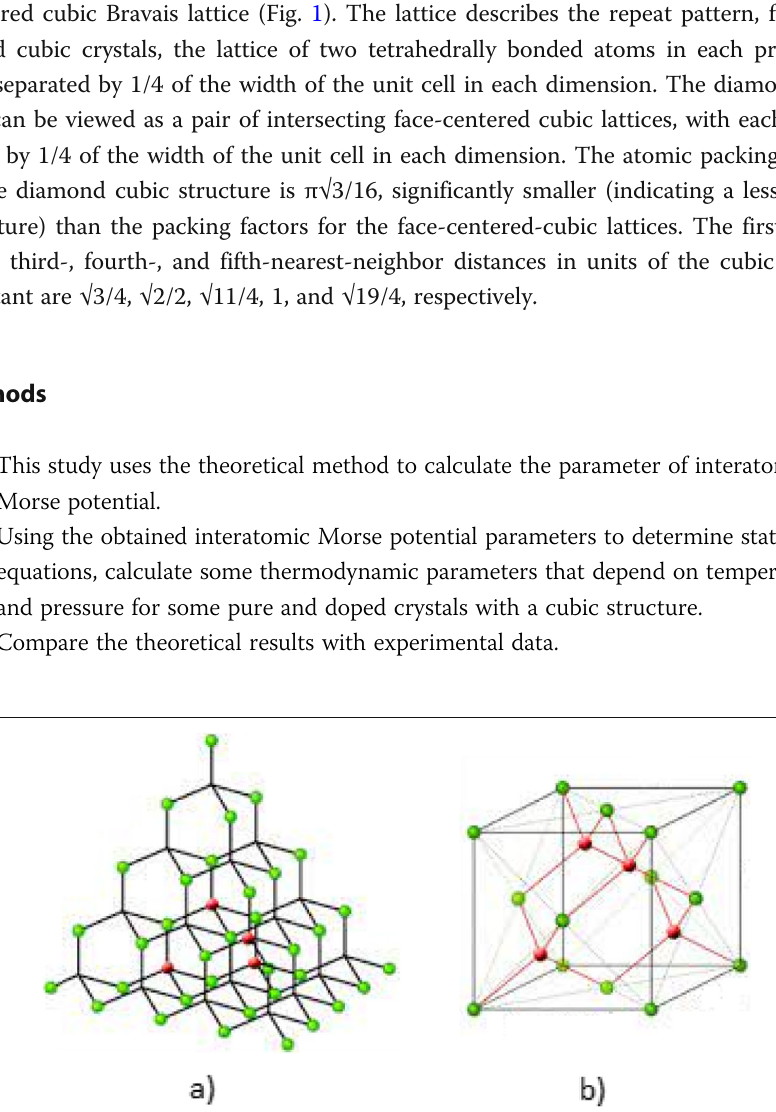
Fig. 1 Style of diamond ’ s cubic structure is in the Fd3m space